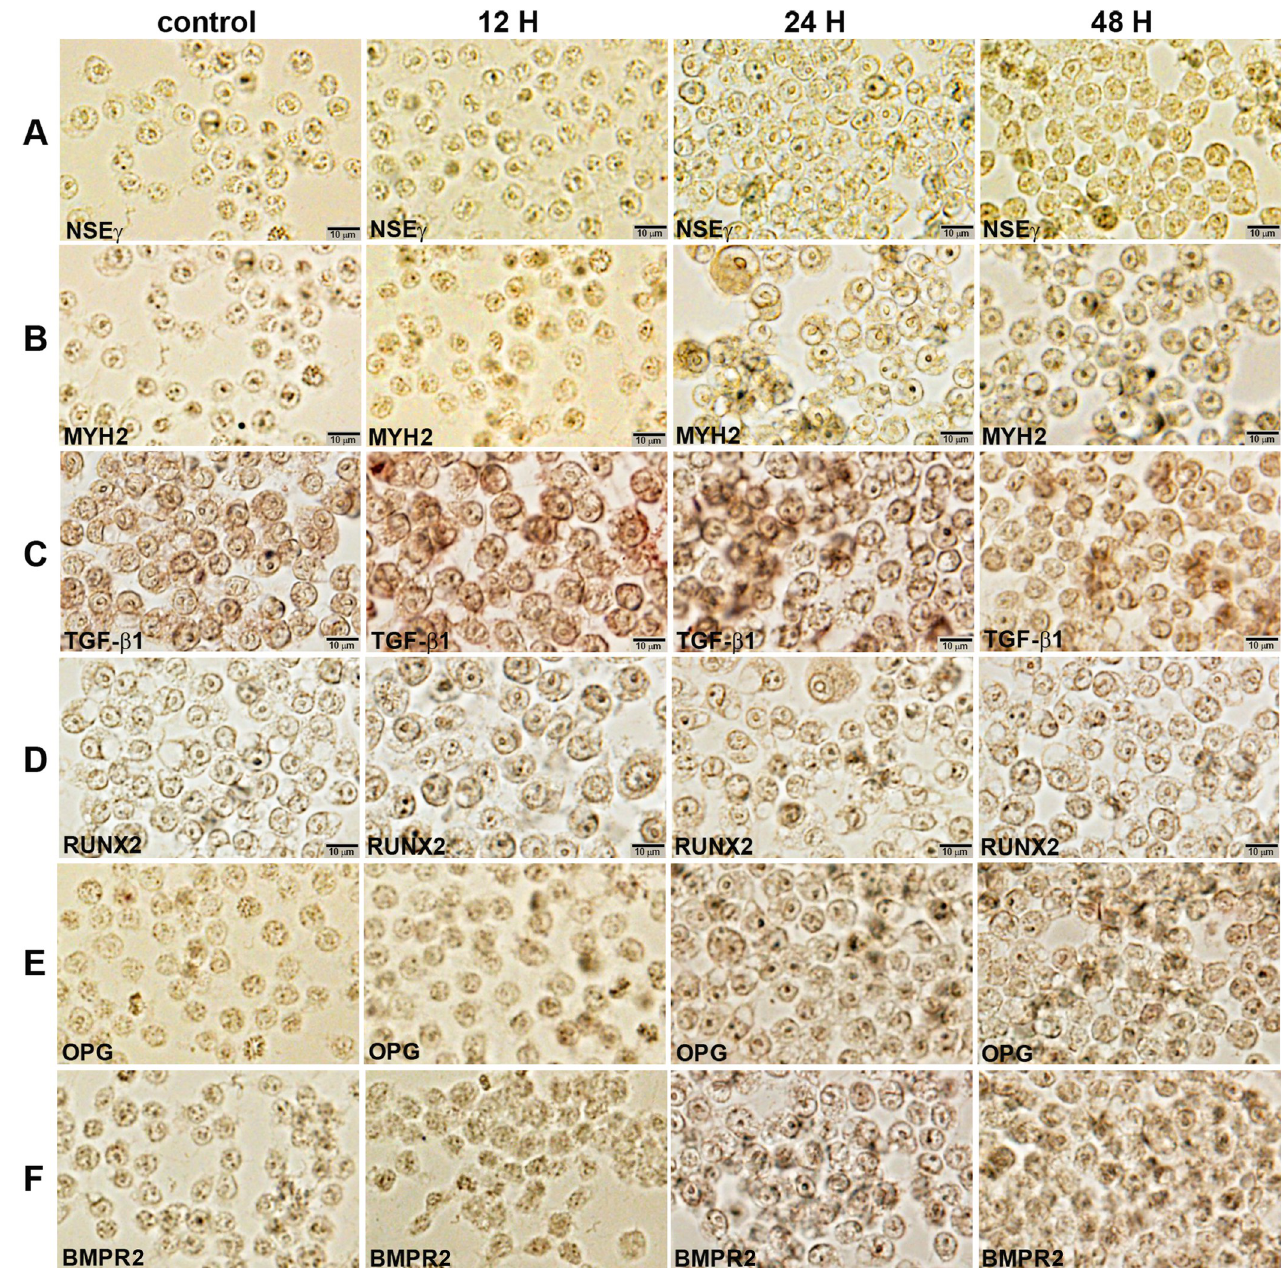
Fig 4. Immunocytochemical staining of NSE γ (A), MYH2 (B), TGF- β 1 (C), RUNX2 (D), OPG (E), and BMPR2 (F) in RAW 264.7 cells after 10 μ g/mL PTX treatment for 0, 12, 24, and 48 hours. Noted the cytoplasmic (arrow heads) and nuclear (arrows) localization of different immunoreactions in monocytic round cells. No counter